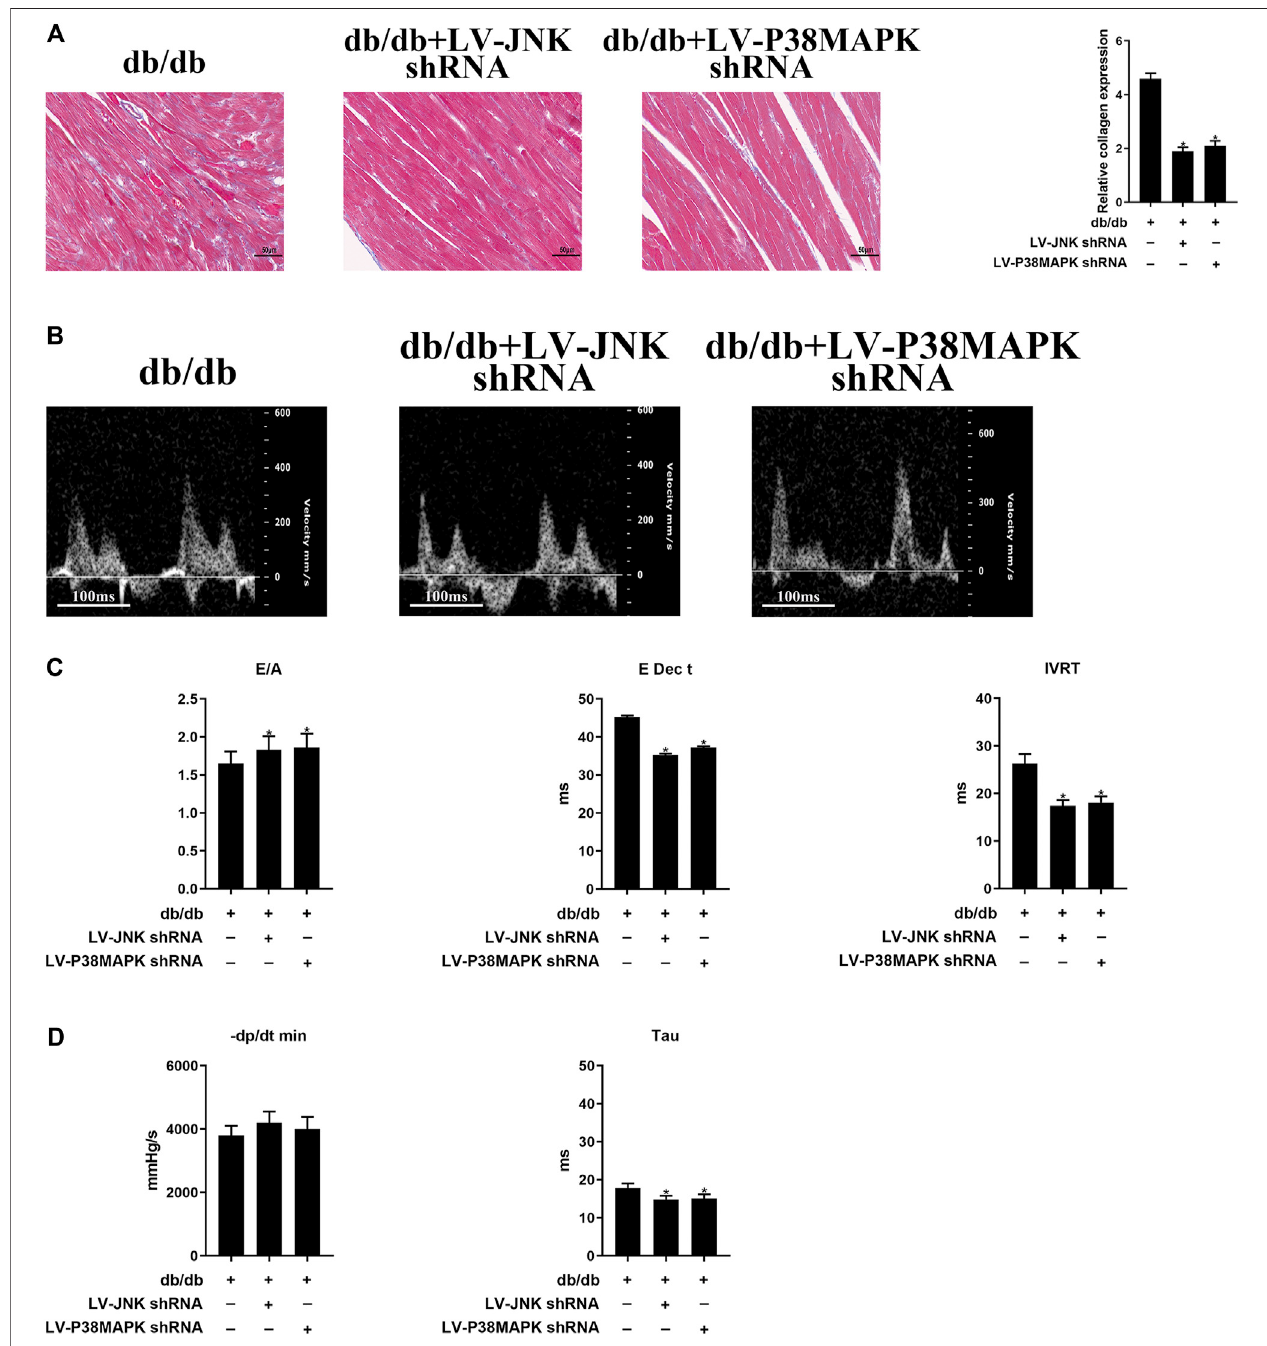
FIGURE 3 | Myocardial fi brosis and cardiac diastolic dysfunction (DD) are ameliorated by the knockdown of JNK or p38 MAPK (A) Masson ʼ s trichrome staining of hearttissue(originalmagni fi cation × 400).Thecolumnsshowthedifferencesincollagenaccumulation.Scalebars,50 μ m (B) Echo-Dopplertracesfortransmitral fl ow (C) Transmitral pulsed-wave Doppler measurements of E/A, E Dec t, and IVRT (D) Hemodynamic parameters: − dP/dt min and the time constant, Tau. The columns show the differences in left ventricular DD and hemodynamic parameters. Data are presented as mean ± SEM ( n (cid:2) 6). p -values were calculated using one-way ANOVA with Tukey multiple comparison test. * p < 0.05, compared to the db/db mice groups.